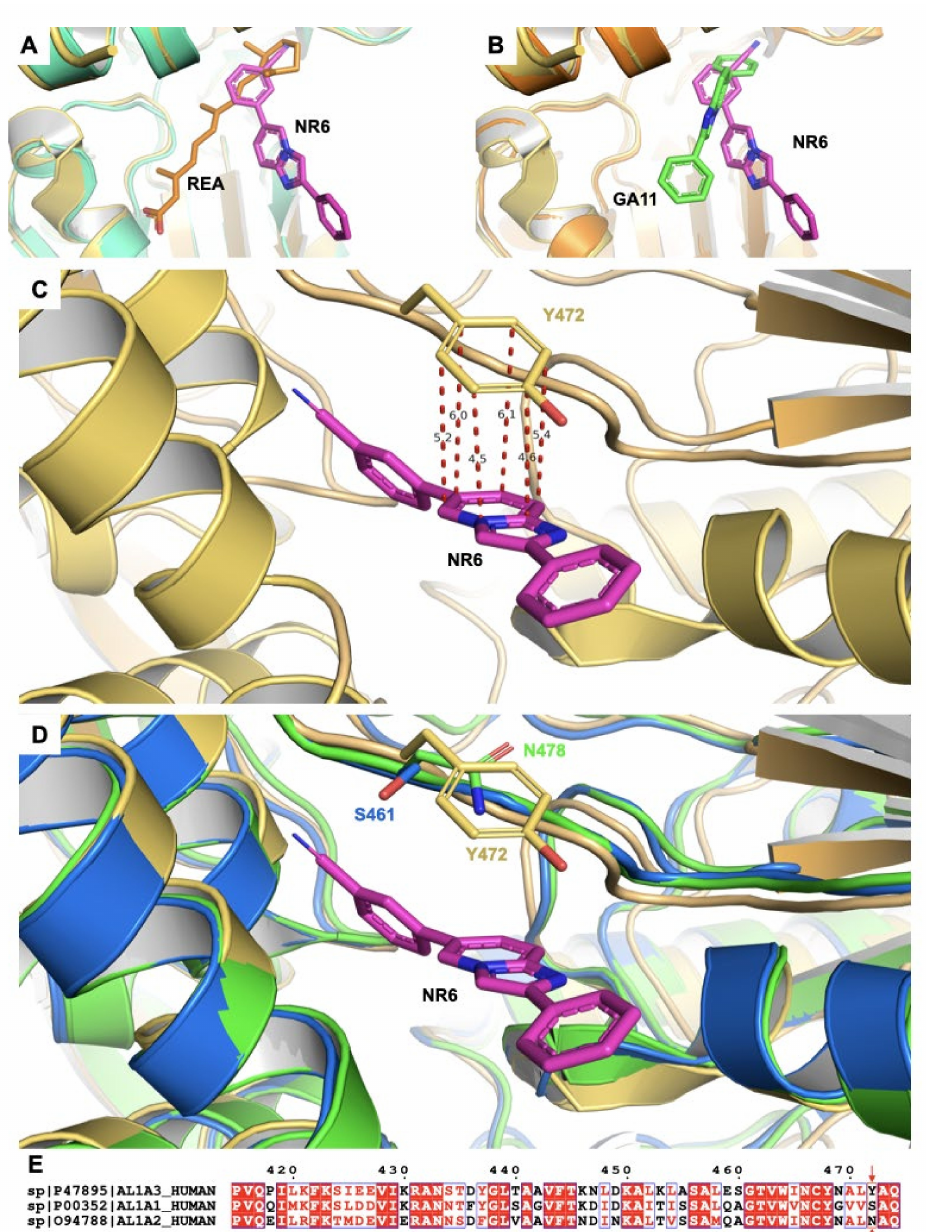
Figure 3. Structural superimposition between the complex ALDH1A3-NR6, other ALDH1A3 complexes (PDB 5FHZ and PDB 6S6W and the ALDH1A1 (PDB 4WB9) and ALDH1A2 (6B5G) to describe the key residue for the selectivity ( A ) Superimposition between monomers A from PDB 5FHZ (turquoise) and monomer A from PDB 7A6Q (yellow), with a focus on the binding region of the retinoic acid (REA) in the open conformation, shared with NR6. In particular, the 6-phenyl ring of NR6 ring conserved the main interactions as the cyclohexene ring of the natural product. ( B ) Superimposition between monomers A from PDB code 6S6W (orange) and monomer A from PDB code 7A6Q (yellow), highlighting the common pose at level of the 6-phenyl ring while the heterocycle is shifted to another region always at the entrance of the catalytic site (the main interaction of GA11 is with F131). ( C ) Focus on the hydrophobic interaction mediated by the tyrosine and the pyridine ring of the heterocycle. The distances between all the single atoms participating to the edge-to-face π - π stacking between the Y472 from ALDH1A3 and NR6 are represented in red. ( D ) Superimposition between ALDH1A3 (yellow, PDB code 7A6Q), ALDH1A1 (blue, PDB code 4WB9) and ALDH1A2 (green, PDB code 6B5G), the tyrosine is not conserved in the other two isoforms. ( E ) Sequence alignment between the three isoforms, a single residue seems to give high selectivity to NR6 against ALDH1A3 toward the other members of the